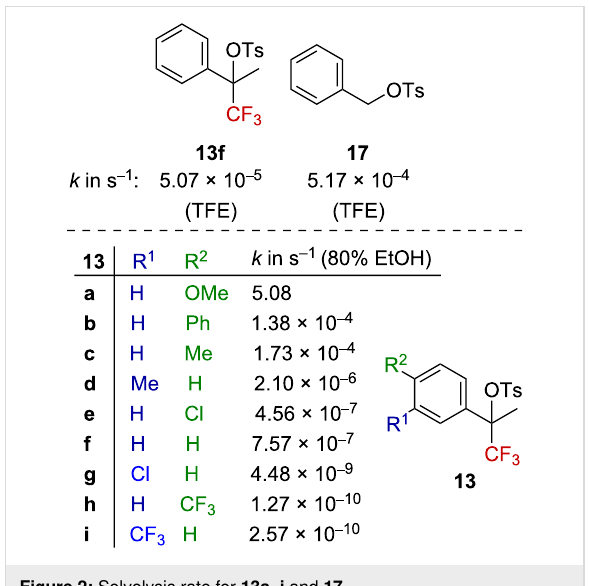
Figure 2: Solvolysis rate for 13a – i and 17 .